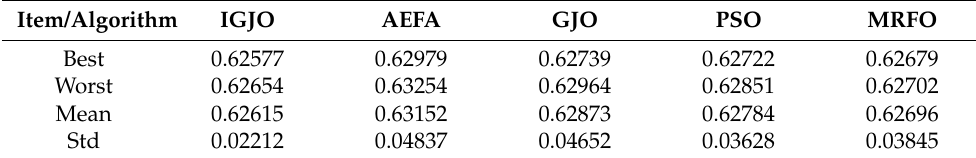
Table 5. The results of a statistic analysis of different